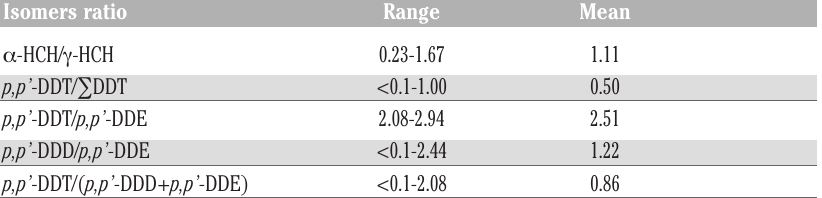
Table 5. Ratio of hexachlorocyclohexane and dichlorodiphenyltrichloroethane isomers in Yamuna River